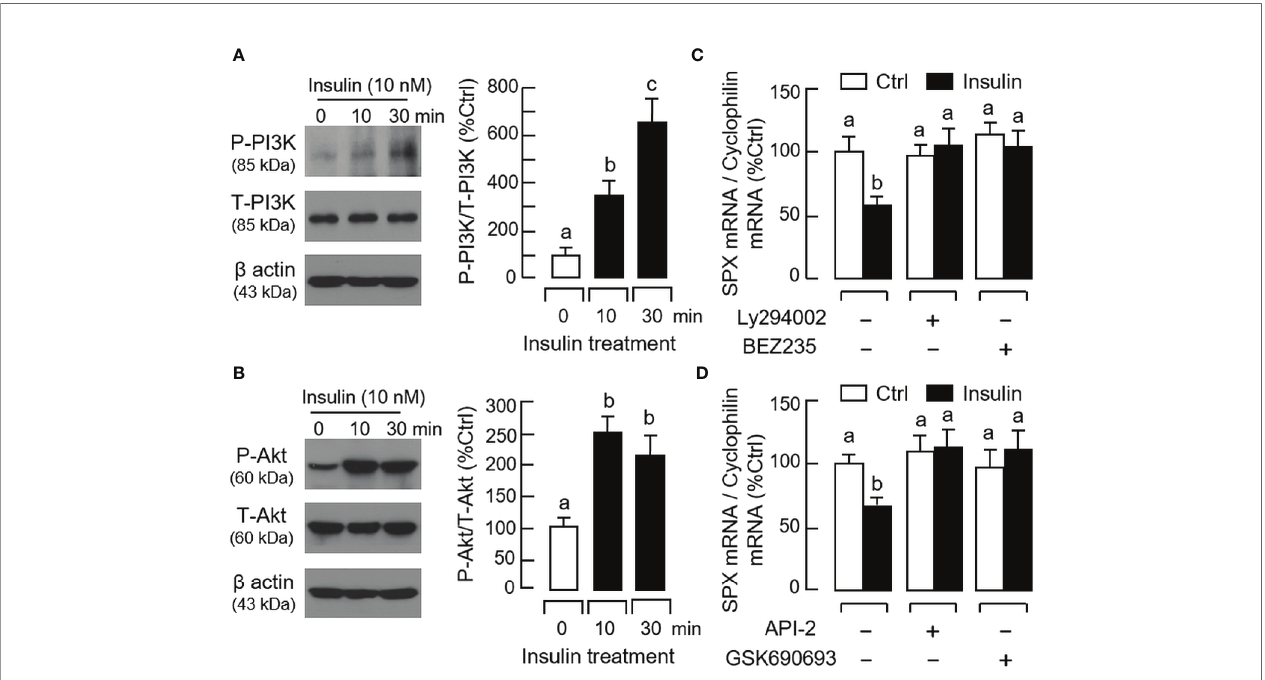
FIGURE 8 | Functional role of PI3K/Akt cascade in insulin inhibition of SPX gene expression in mouse gastric mucosal cells. Insulin treatment (10 nM) up to 30 min on (A) PI3K and (B) Akt phosphorylation in gastric mucosal cells using Western blot with antibodies for the phosphorylated form ( “ P- ” form) and total protein ( “ T- ” form) of respective targets. Parallel blotting for b actin was used as internal control. Co-treatment with (C) the PI3K inhibitors Ly294002 (10 µM) or BEZ235 (400 nM), and (D) the Akt inhibitors API-2 (20 µM) or GSK690693 (15 nM), respectively, on insulin inhibition (10 nM) of SPX gene expression in gastric mucosal cells. In these studies, the duration of drug treatment was fi xed at 24 h. Data presented (mean ± SEM, N = 8) were analyzed by one-way ANOVA followed by Newman-Keuls test and the groups denoted by different letters represent a signi fi cant difference at p <